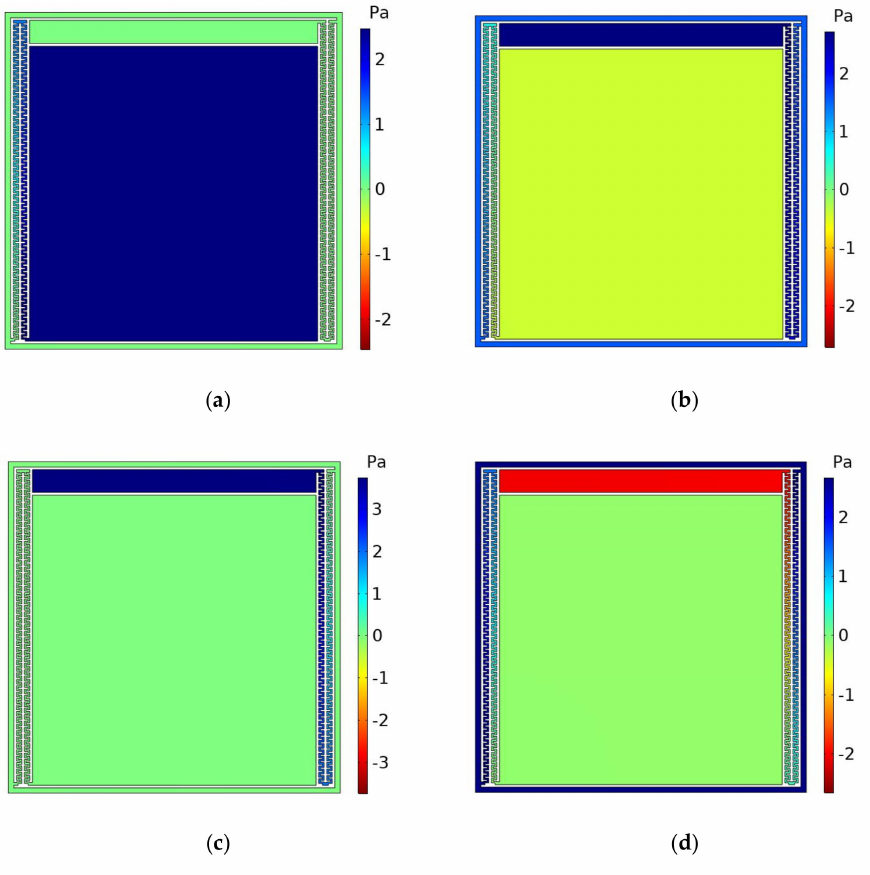
Figure 7. The sound pressure distribution diagram of point A ( a ), point B ( b ), point C ( c ) and point D ( d